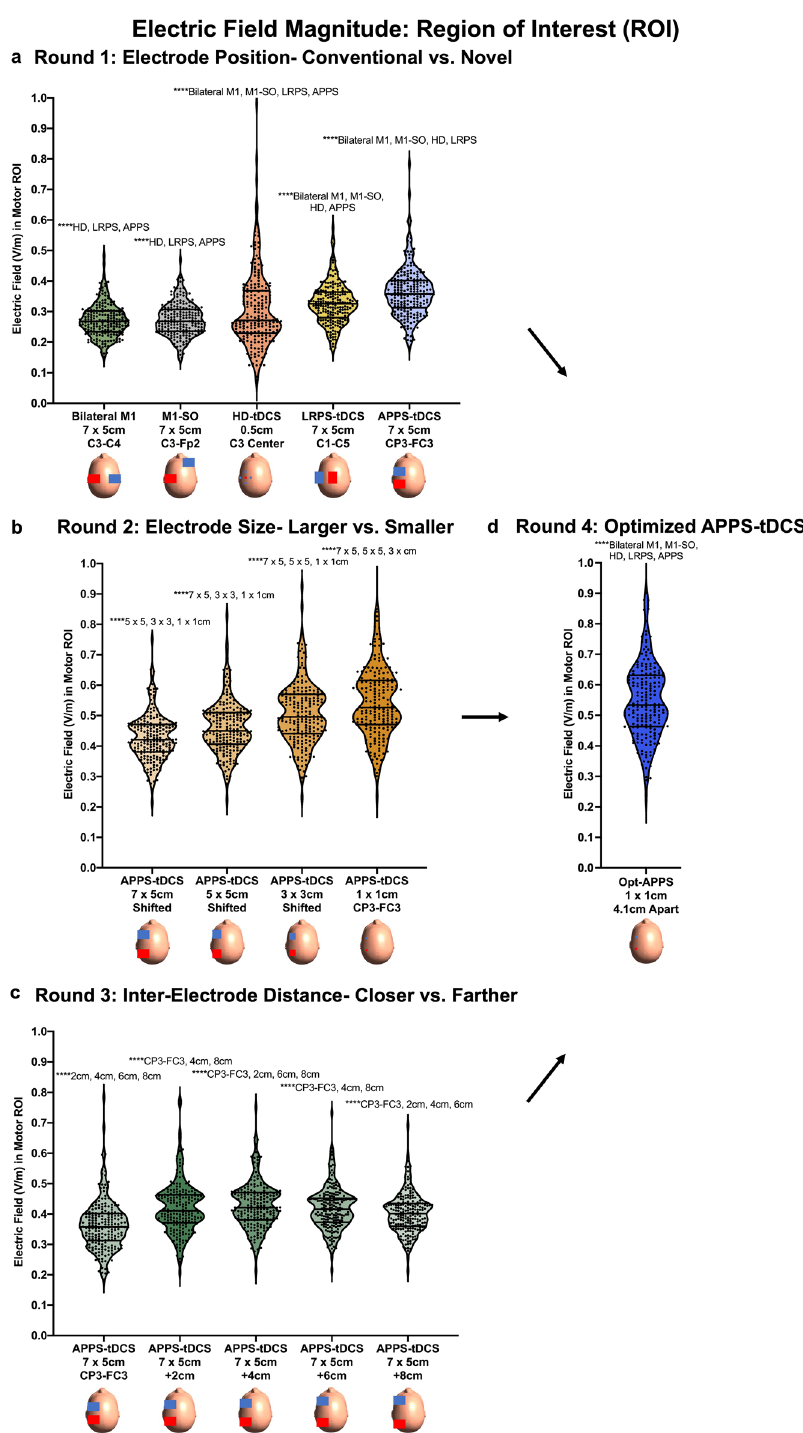
Figure 4. Electric Field Magnitude Results: Region of Interest (ROI) Analysis. This figure shows the E-field magnitudes at the motor ROI. ( a ) Round 1 E-field modeling demonstrated that placing electrodes surrounding the cortical target in anterior posterior pad surround (APPS)-tDCS produced significantly higher E-fields of 0.363 V/m (SD = 0.081 V/m), compared to 0.271 and 0.273 V/m in the bilateral M1 and M1-SO montages respectively (both SD = 0.053 V/m). ( b ) Round 2 E-field modeling showed how the smaller 1 × 1 cm electrode size resulted in significantly higher E-fields of 0.549 V/m (SD = 0.133 V/m), compared to 0.428 V/m (SD = 0.077 V/m) for the 7 × 5 cm electrode. ( c ) Round 3 E-field modeling showed a non-linear increase in E-field magnitude with greater distance, with the CP3-FC3 + 2 cm (mean = 0.421 V/m, SD = 0.084 V/m) and + 4 cm (mean = 0.428 V/m, SD = 0.077 V/m) inter-electrode distances producing the significantly highest E-field magnitudes. d) Round 4 E-field modeling used optimized parameters of APPS-tDCS with 1 × 1 cm electrodes that were placed an average of 4.12 cm apart. This optimized APPS-tDCS paradigm produced the highest E-field magnitude of 0.553 V/m (SD = 0.138 V/m), which was significantly higher than the E-field magnitude in each of the Round 1 modeling montages. **** p < 0.0001 (Tukey